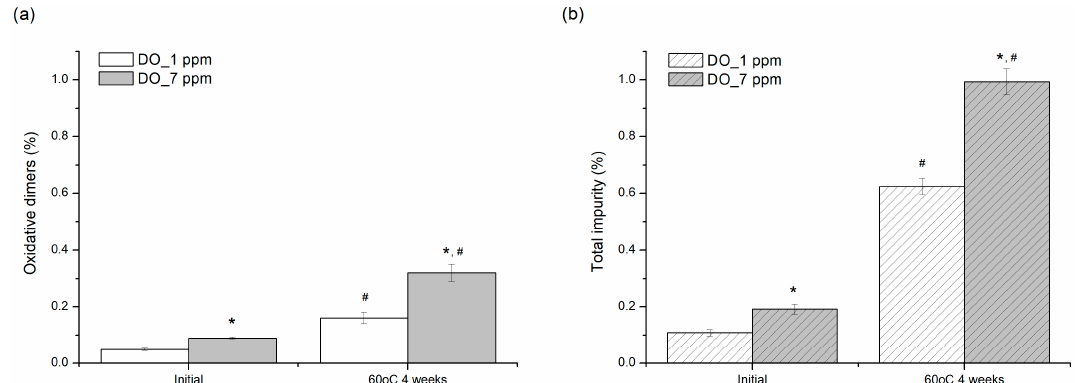
Figure 7. Effect of DO level (ppm) on pemetrexed degradation in aqueous solution induced by stress condition at 60 °C for four weeks: ( a ) increase in oxidative dimers and ( b ) increase in total impurity. * indicate significant difference compared to 1 ppm DO ( p < 0.05); # indicate significant difference compared to initial value ( p < 0.05).